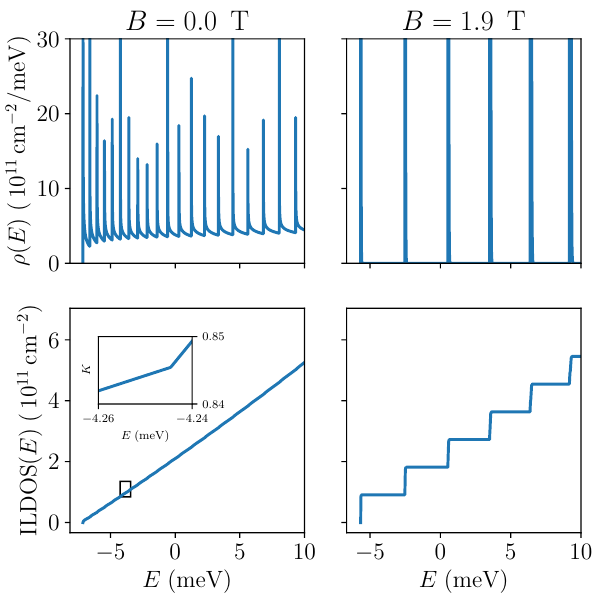
( E ) (LDOS) at the center of the gas ( x = 0 ) Figure 3: Top: Local density of states ρ i under B = 0 T (left) and B = 1.86 T (right) as a function of energy for the geometry of Fig. 1(b). Bottom: Integral of the local density of states (ILDOS) for the same = − 1 V. Inset: zoom of the main curve showing magnetic fields. The gate voltage is V (cid:112) G E singularity of the the cusp created by the 1 /